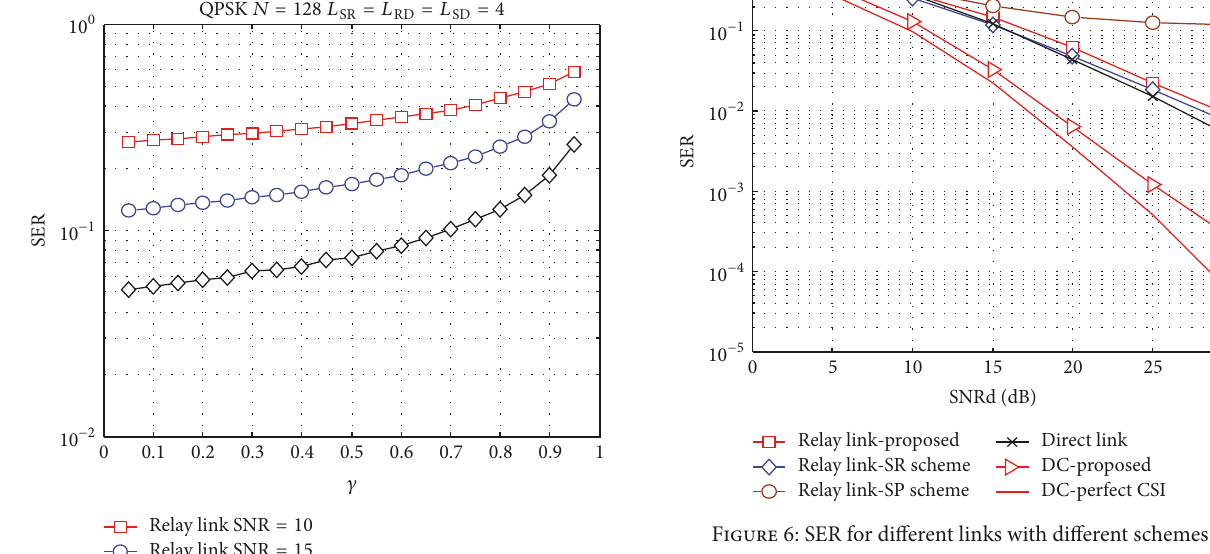
Figure 6: SER for different links with different